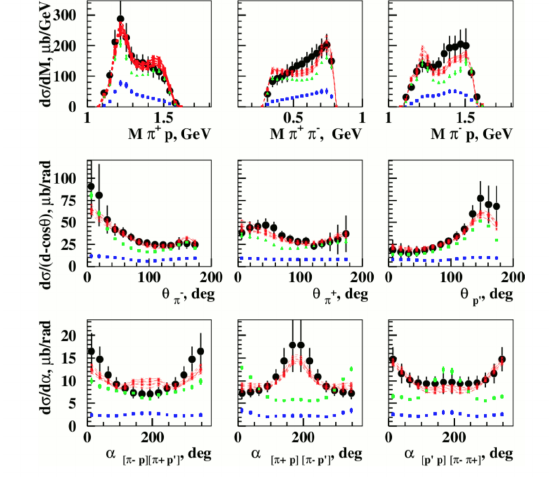
Fig. 3. (Color online) Two pion photoproduction 1-fold differential cross sections (black circles) for W = 1.74 GeV and the resonant/non-resonant contributions (blue/green points) from the JM model fits (red curve).